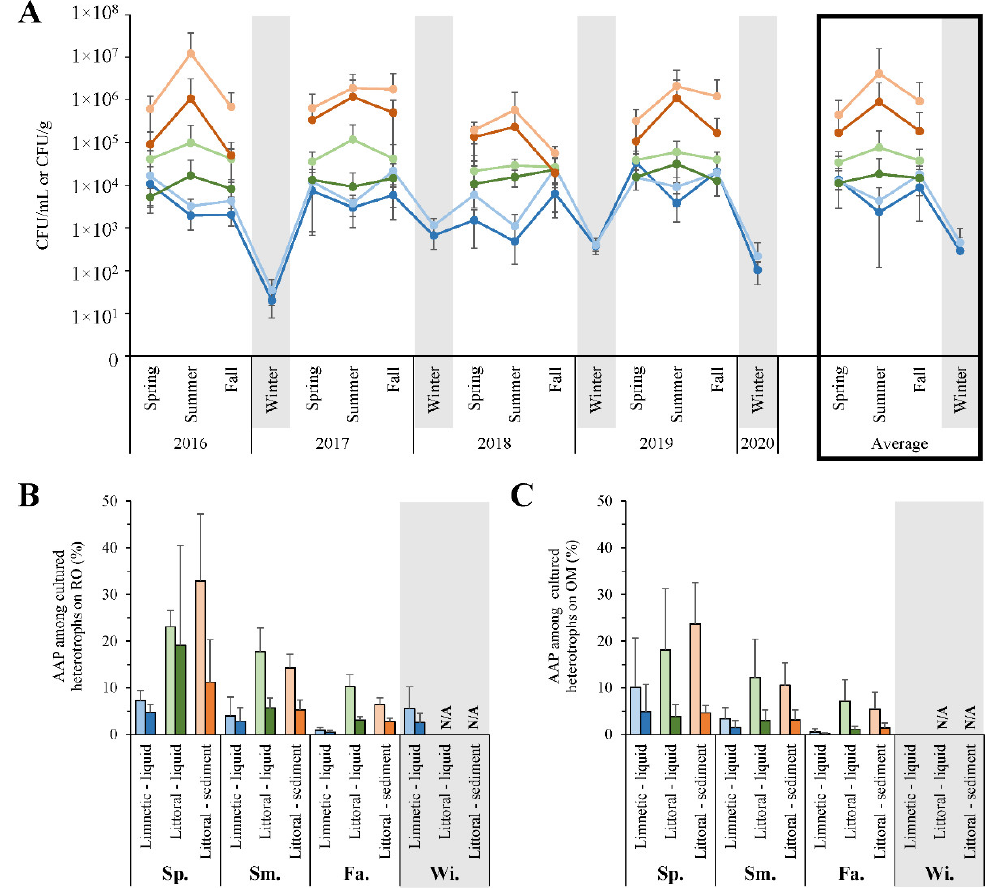
Figure 4. Enumeration of heterotrophs and AAP through all seasons and years. ( A ) Counts of total cultured heterotrophs from limnetic water (blue), littoral water (green), or sediment (orange) samples on copiotrophic RO (dark colors) or oligotrophic OM (lighter shade of each). ( B ) Copiotrophic and ( C ) oligotrophic AAP proportions of pigmented colonies (light shade) and total counts (dark shade) of seasonal averages from 2016–2020. N/A, not analyzed; Sp., Spring; Sm., Summer; Fa., Fall; Wi., Winter.